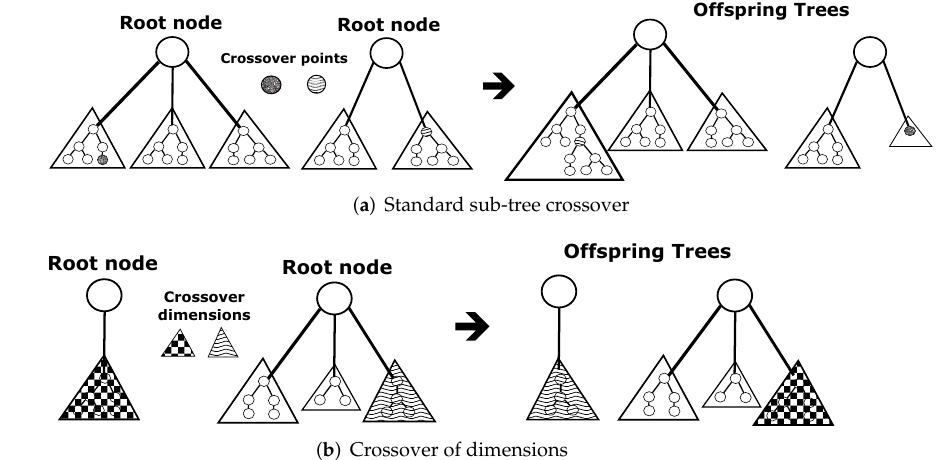
Figure 7. The two possible crossover types in M3GP, standard sub-tree and